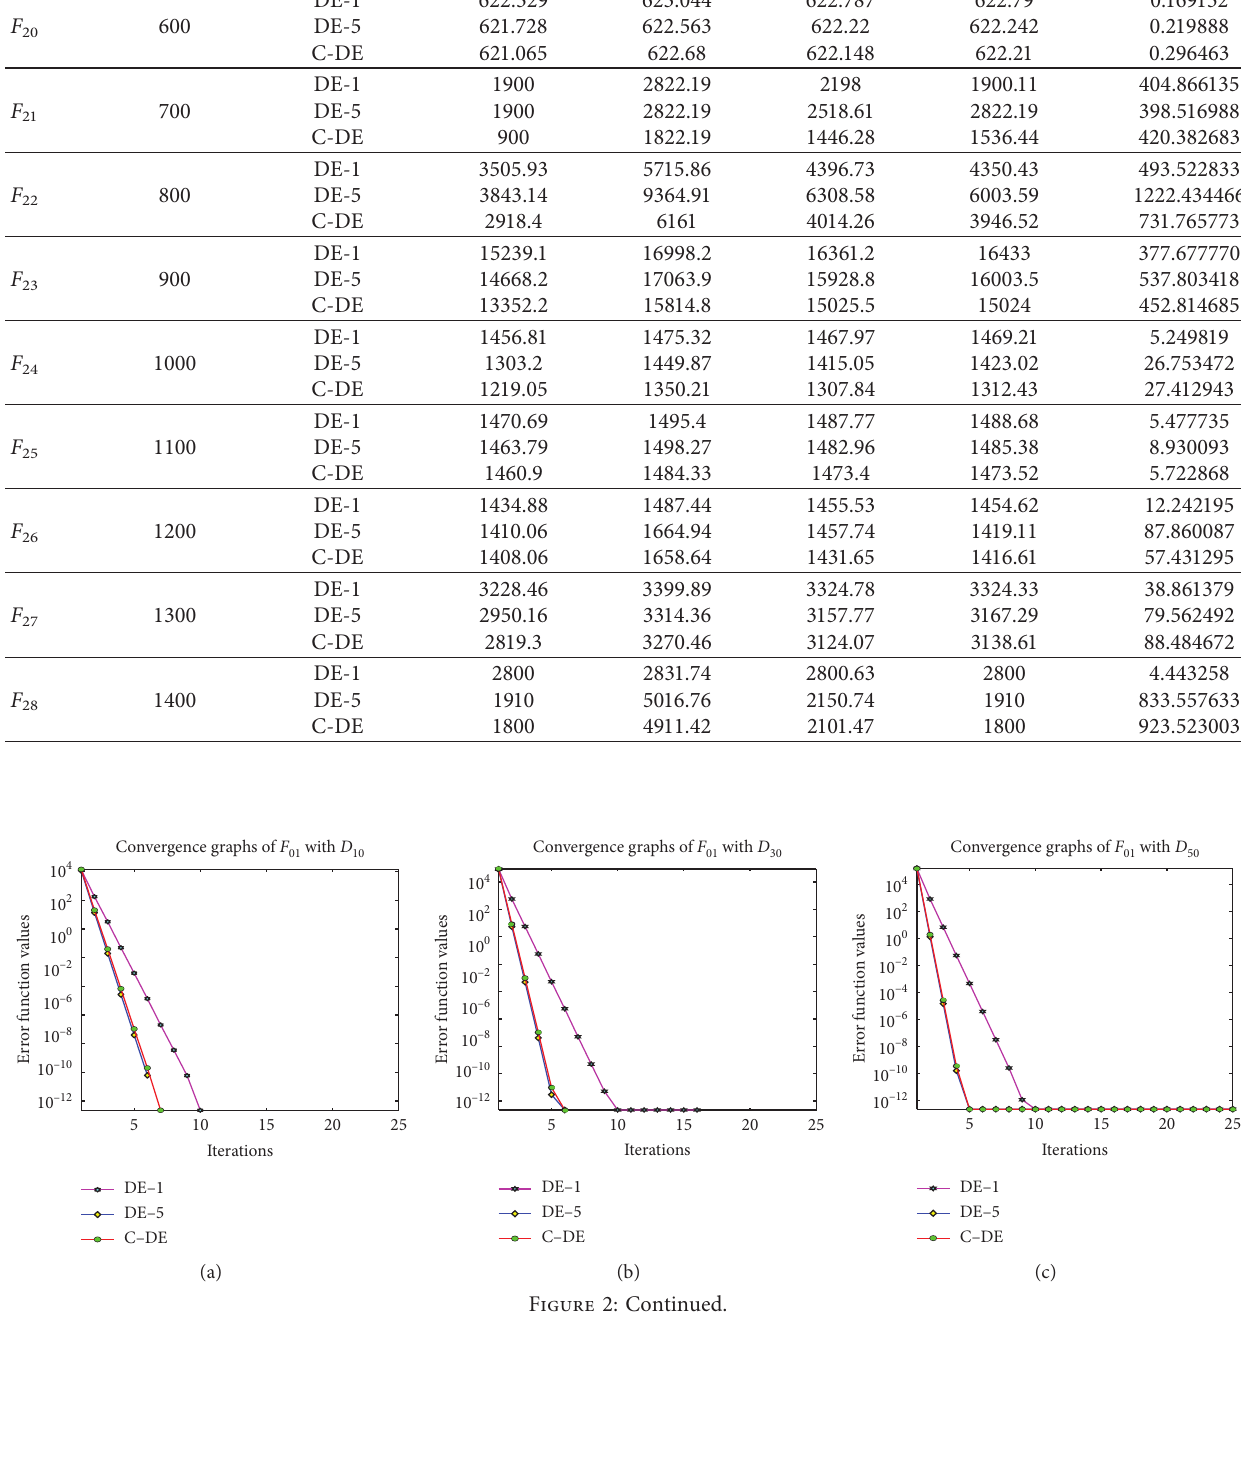
Table 7: The experimental results obtained by DE-1 and DE-5 versus proposed C-DE by solving CEC’13 benchmark functions F n � 50 dimensions. P.